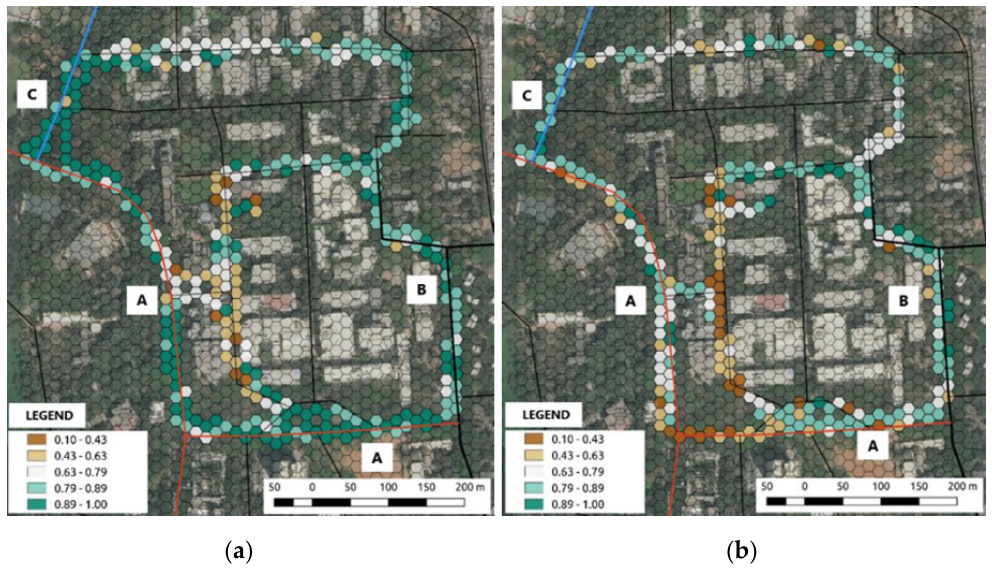
Figure 4. Percentage of naturalness during the morning ( a ) and evening ( b ). Note: The legend explains the percentage of naturalness (Very low: 0.10–0.43, low: 0.43–0.63, medium: 0.63–0.79, high: 0.79–0.89, very high: 0.89–1.0).